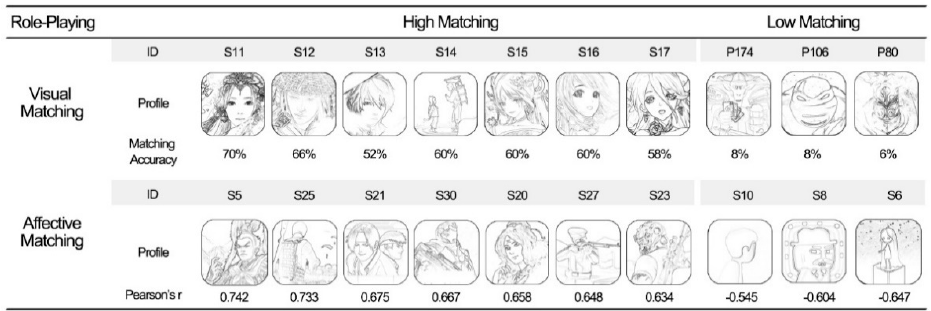
Figure 5. Strategy game icons with high perceptual matching.